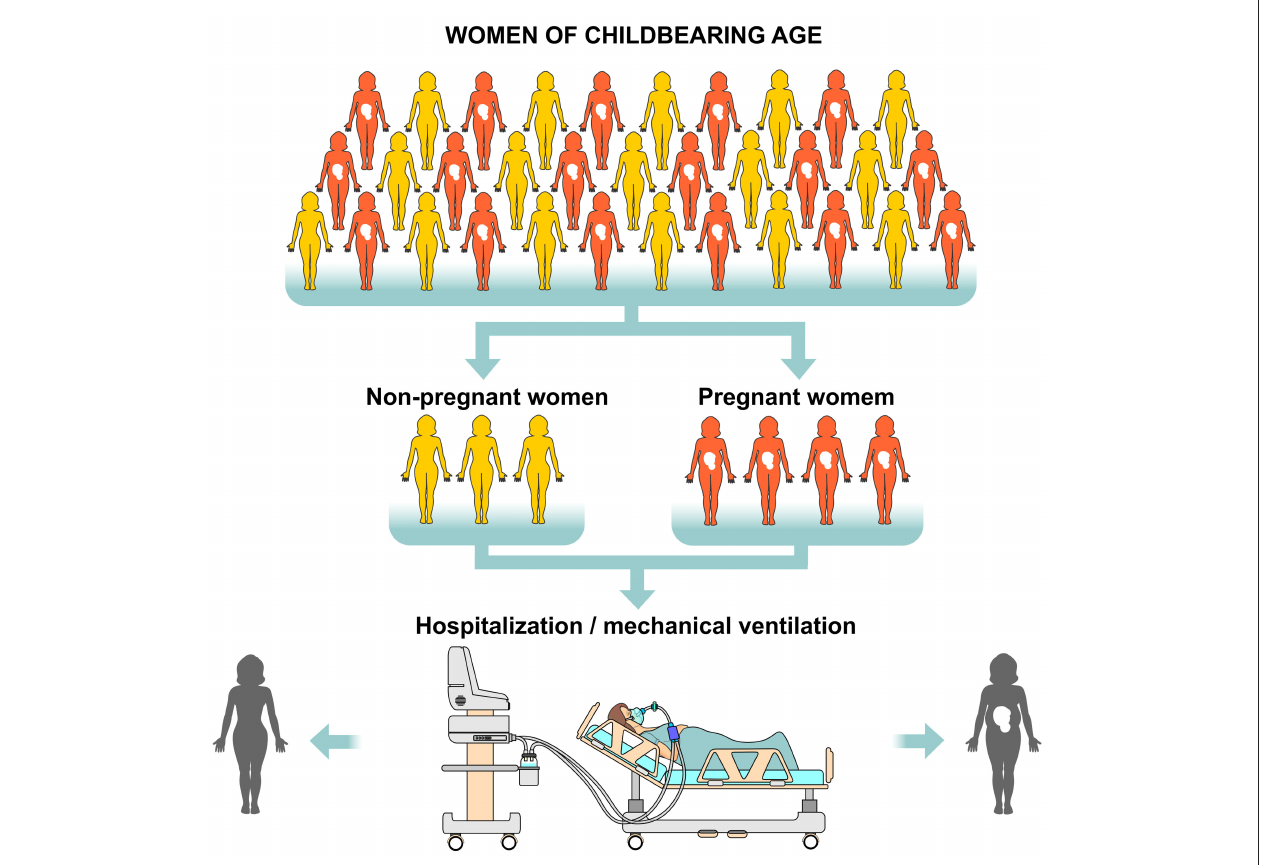
FIGURE 8 | Risk of hospitalization and need for mechanical ventilation in women of childbearing age with SARS-CoV-2. Considering all women of childbearing age (pregnant and non-pregnant) who are positive RT-PCR (Reverse Transcription Polymerase Chain Reaction) for the virus, pregnant women are at greater risk of being hospitalized and requiring mechanical ventilation. However, the mortality rate is identical in both pregnant and non-pregnant groups.